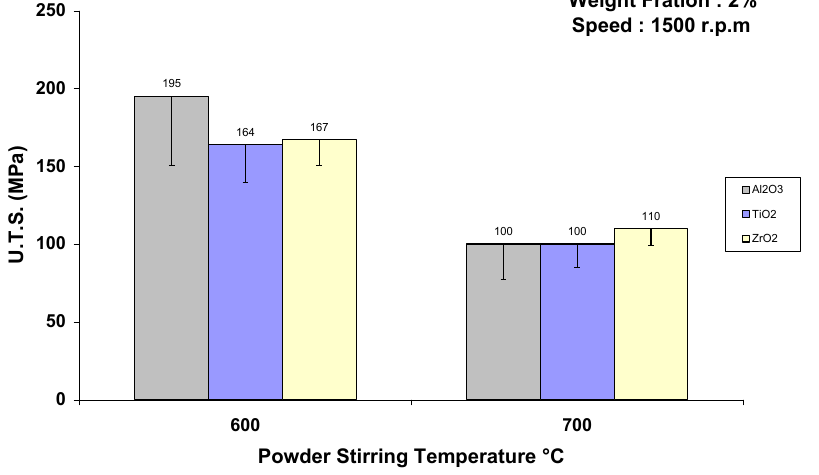
Figure 8. The effect of stirring temperature on the UTS at 1500 rpm stirring